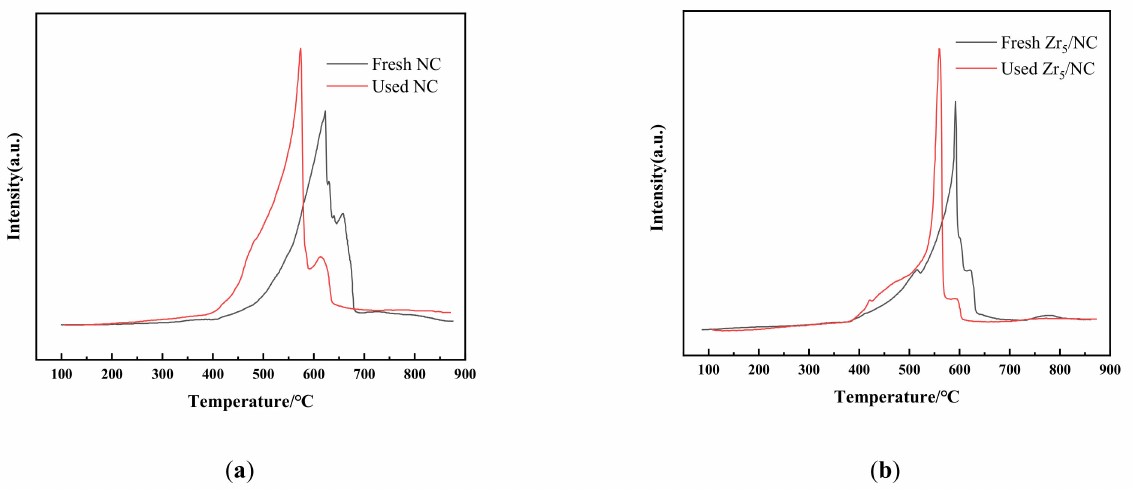
Figure 4. H 2 -TPR profiles. ( a ) The intensity signal with temperature of NC, and ( b ) The intensity signal with temperature of Zr 5